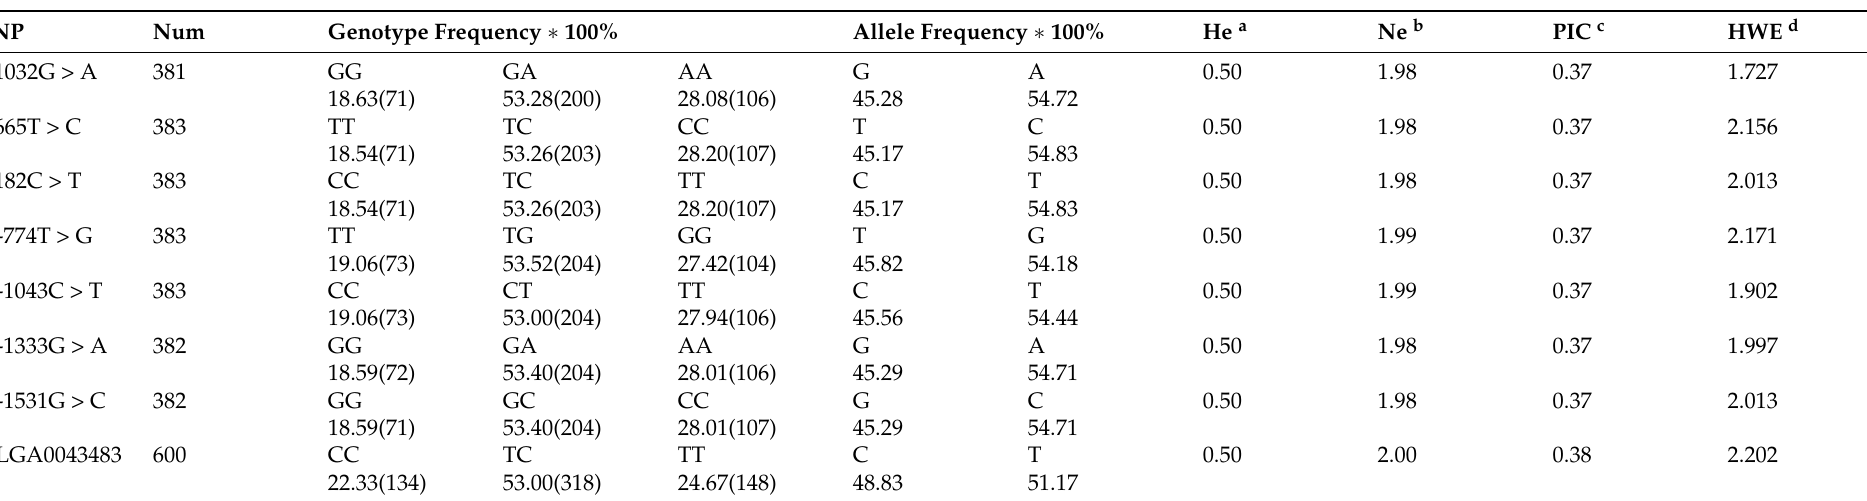
Table 2. Genotypes, allele frequencies and genetic diversity for ALGA0043483 and the seven SNP sites for GPX2, which were genotyped from 383 Duroc